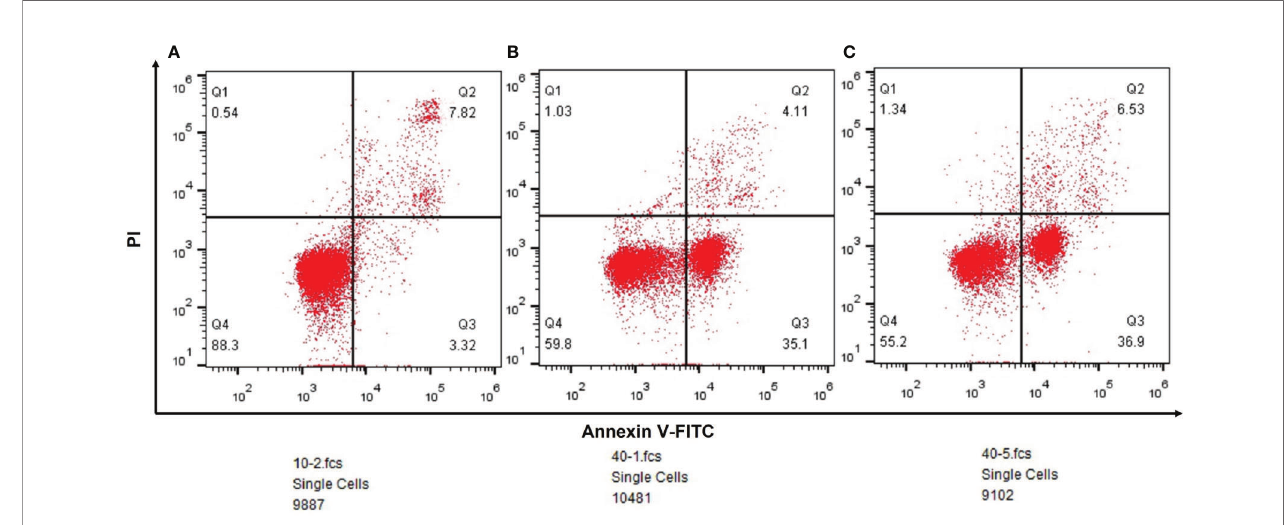
FIGURE 7 | (A) The outcomes of fl ow cytometry in paracancerous tissues. (B) The outcomes of fl ow cytometry in lung squamous cell carcinoma. (C) The outcomes of fl ow cytometry in lung